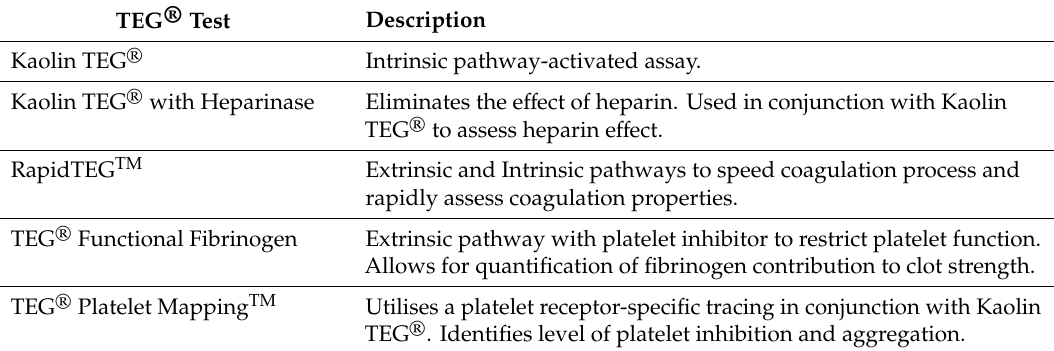
Figure 6. Plot of the total deflection of the pin from the TEG ® 5000 system. The primary values that are derived from the resulting waveform are reaction time (R, or activated clotting time [ACT]), maximum amplitude (MA) and lysis at 30 minutes (LY30). R represents the time to the beginning of clot formation. MA is the maximum clot strength achieved. LY30 quantifies the reduction of clot strength, or the lysis (in the 30 min) following MA. K and α angle are also used to quantify the dynamics of clot formation. Reproduced from [12]. Table 1. Assays developed for the TEG ® 5000 system.